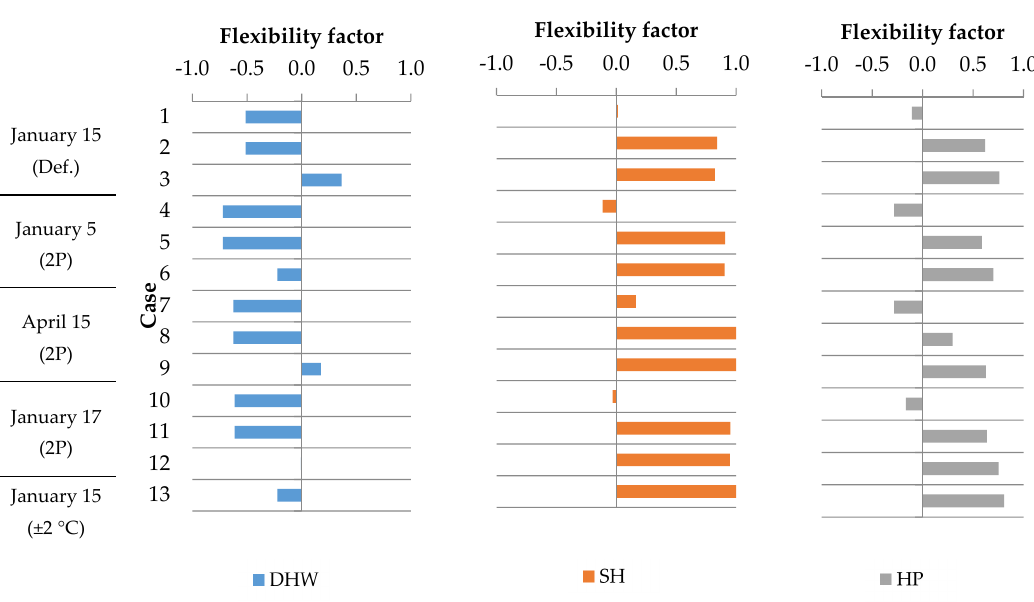
Figure 6. Flexibility factor analysis. Domestic Hot Water (DHW) refers to the flexibility factor computed using the heat pump power for the production of DHW. Space heating (SH) refers to the flexibility factor computed using the heat pump power for space heating. HP refers to the flexibility factor computed using the total heat pump power (DHW and SH).